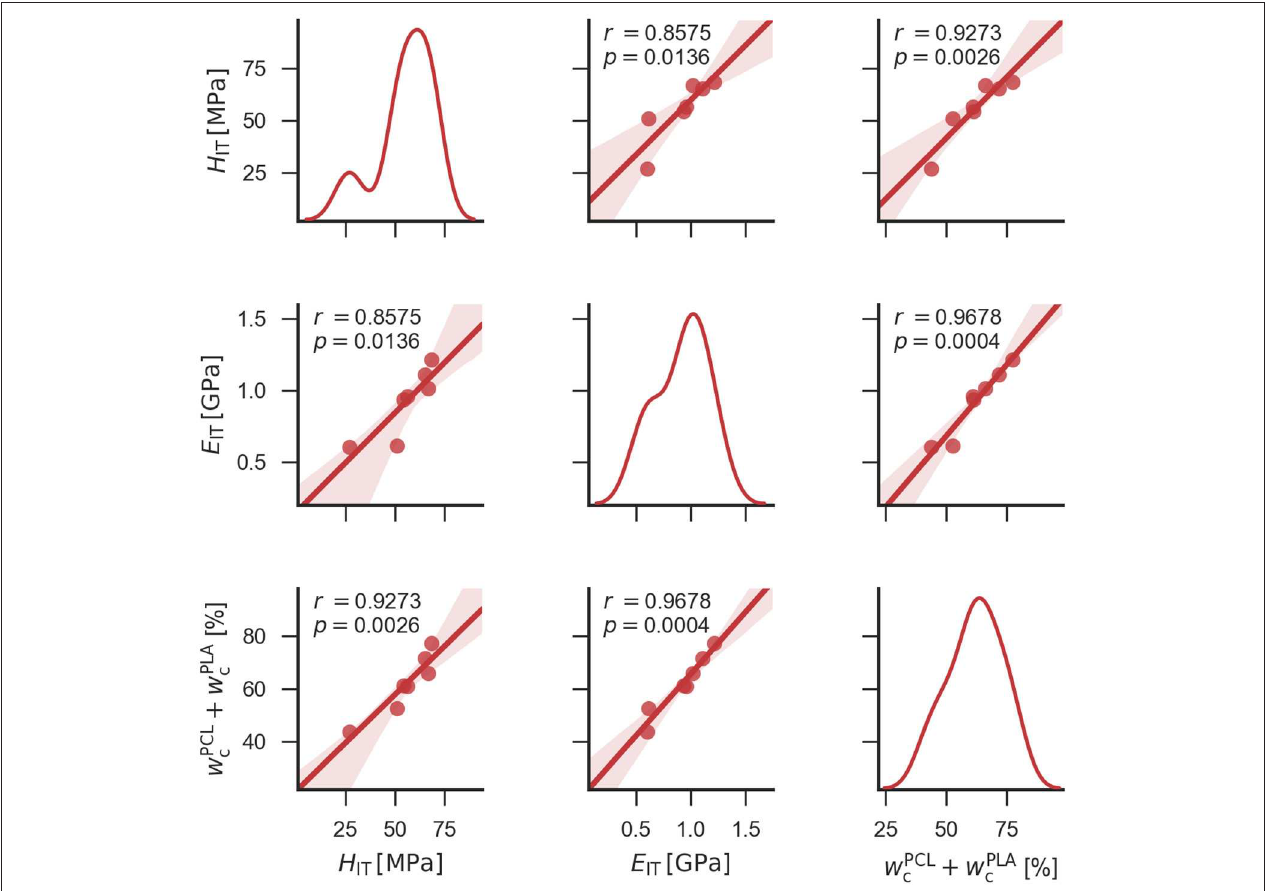
FIGURE 5 | Scatterplot matrix graph showing correlations among indentation hardness ( H IT ), indentation modulus ( E IT ) and sum of crystallinities of PCL and PLA ( w PCL c + w PLA c ). Diagonal elements of the graph display distribution of each quantity, while off-diagonal elements show correlations between each pair of quantities. Off-diagonal elements display also Pearson’s correlation coefficients ( r ) and p -values ( p ). The scatterplot matrix graph, correlation coefficients and p -values were calculated with Python modules as described in Experimental